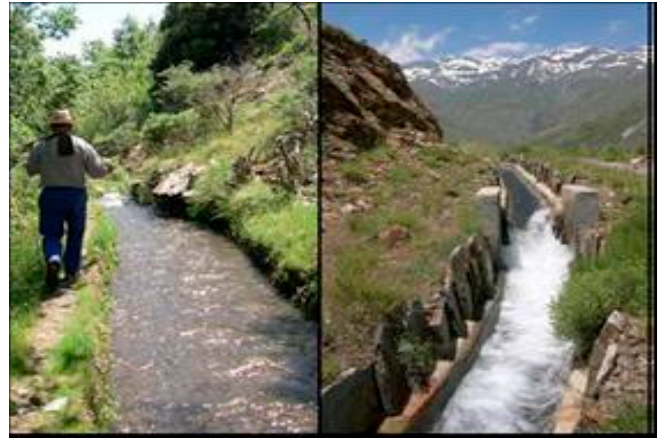
Figure 16. Views of the Acequia Nueva, watershed of the Poqueira River (adapted from [128]).